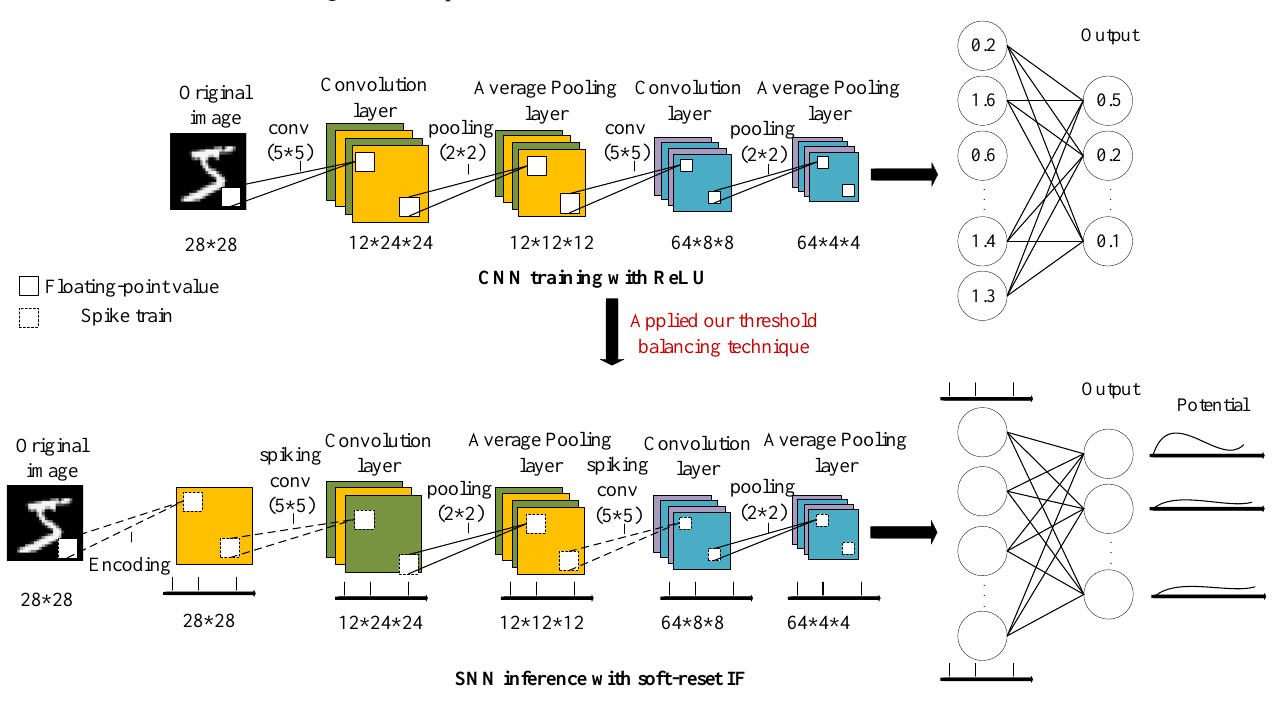
Figure 5. Our CNN-SNN conversion